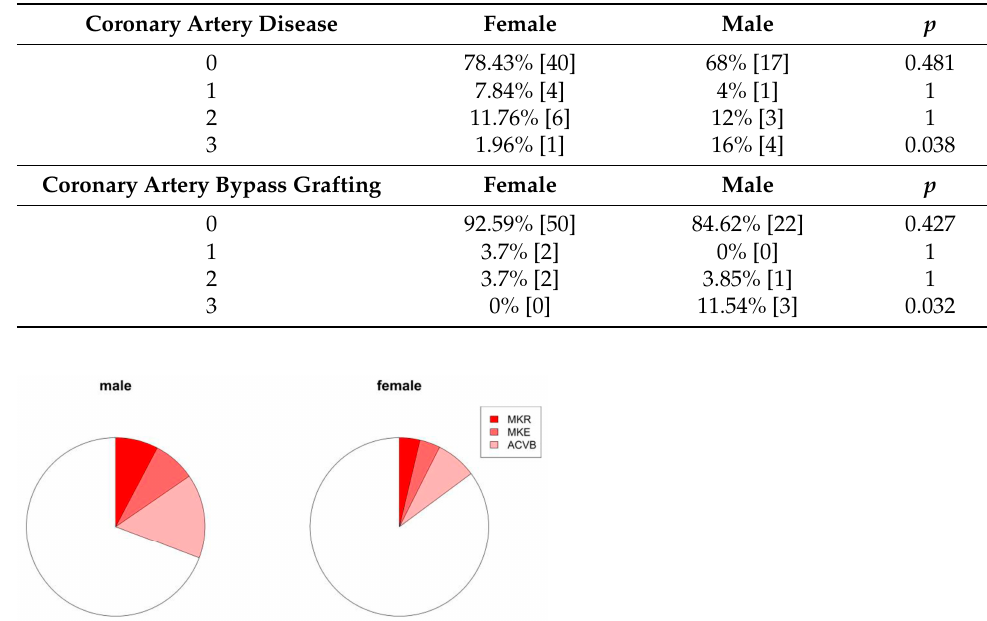
Figure 3. Proportion of concomitant procedures in patients with myxoma. MKR: mitral valve reconstructions, and MKE: mitral valve replacement and ACVB: coronary artery bypass graft).